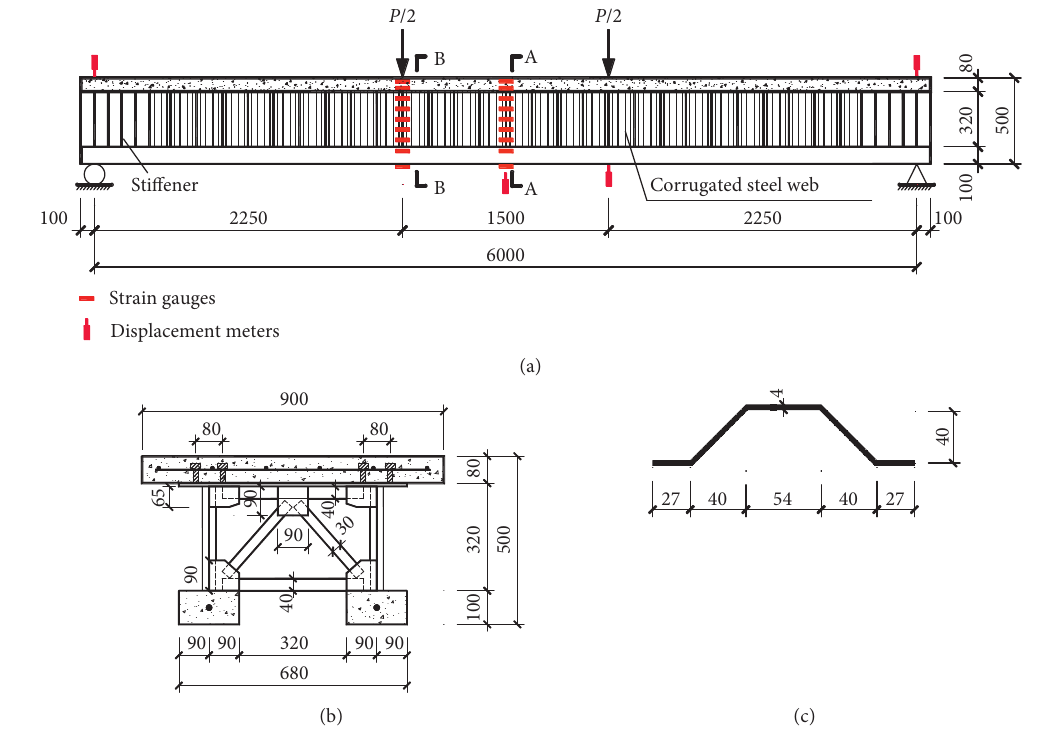
Figure 1: Schematic diagram of innovative posttensioned composite beam (IPCB) with corrugated steel webs (CSWs). P /2 P /2